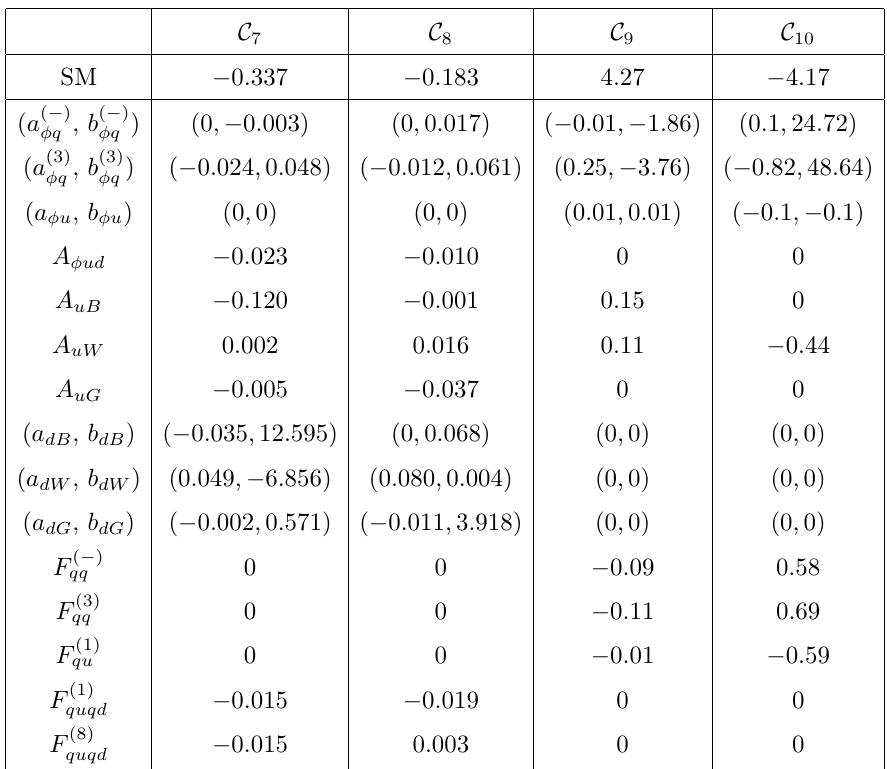
Table 8 . Contributions of SMEFT coefficients C ( m Z ) to the real part of the WET coefficients C ( m b ) in MFV with up-alignment. The SMEFT coefficients are matched onto WET at µ = m Z at one-loop level in the electroweak theory and then RG-evolved down to µ = m scale of new physics has been set to Λ = 1 TeV . Contributions to C the operators considered in this